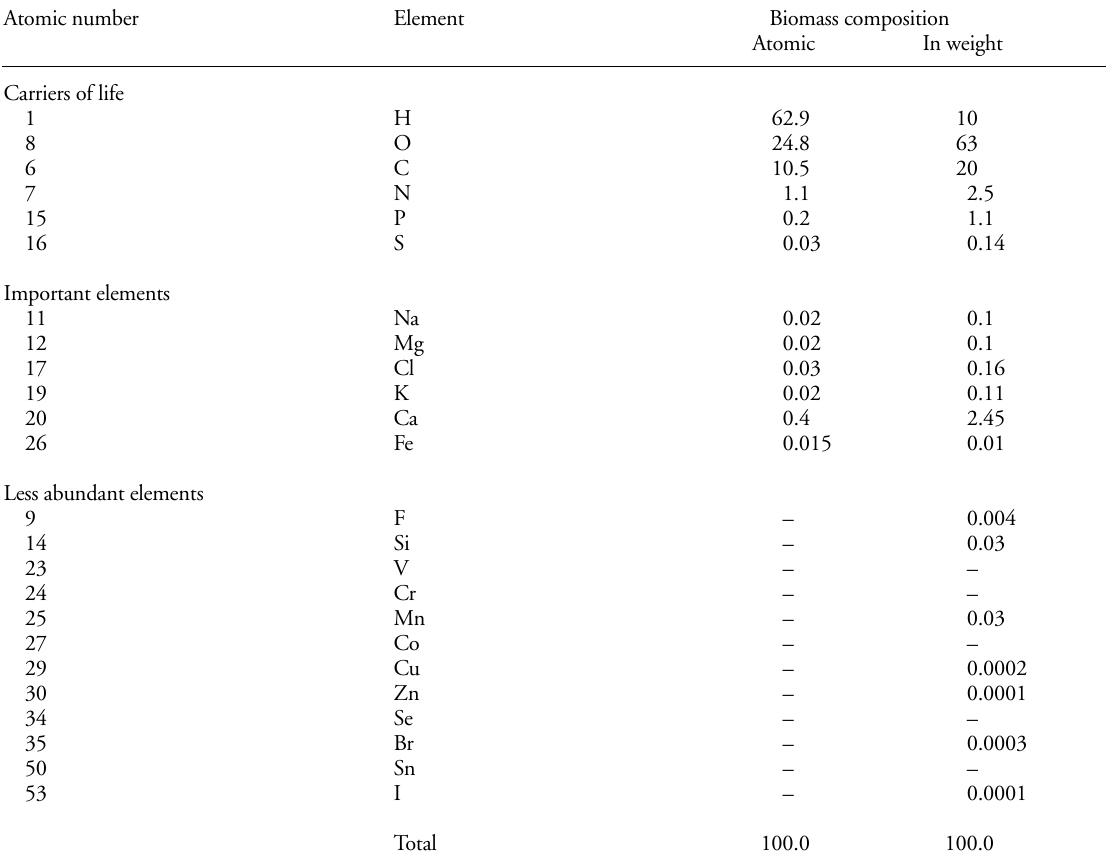
Table 2. Elementary composition of the “terrestrial” biosphere (Taube 1992, Table